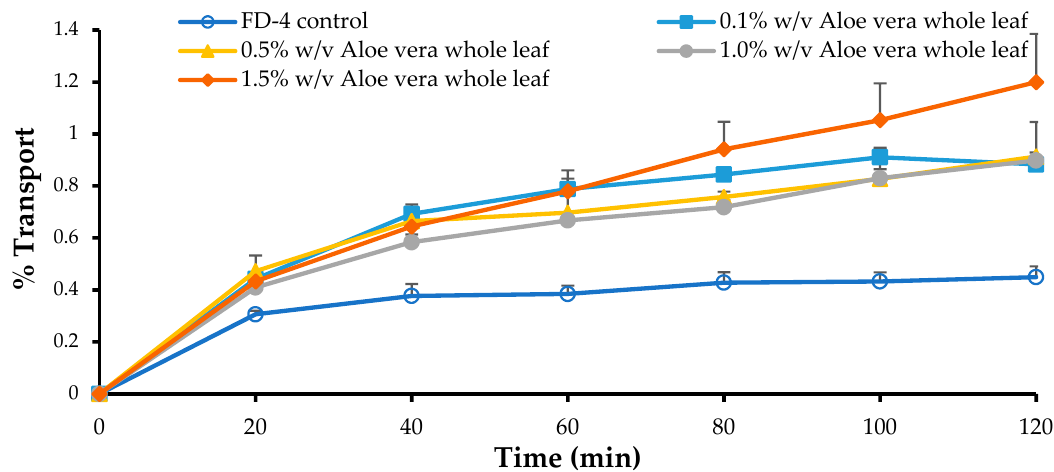
Figure 5. Apparent permeability coefficient (P app ) values of the FITC-dextran (FD-4 with MW of 4 kDa), across the Caco-2 cell monolayers, when co-applied with the Aloe vera gel solutions. Bars marked with an asterisk (*) indicate statistical significant differences from the control ( p < 0.05) ( n = 3; error bars represent SD) (R = permeation-enhancement ratio).